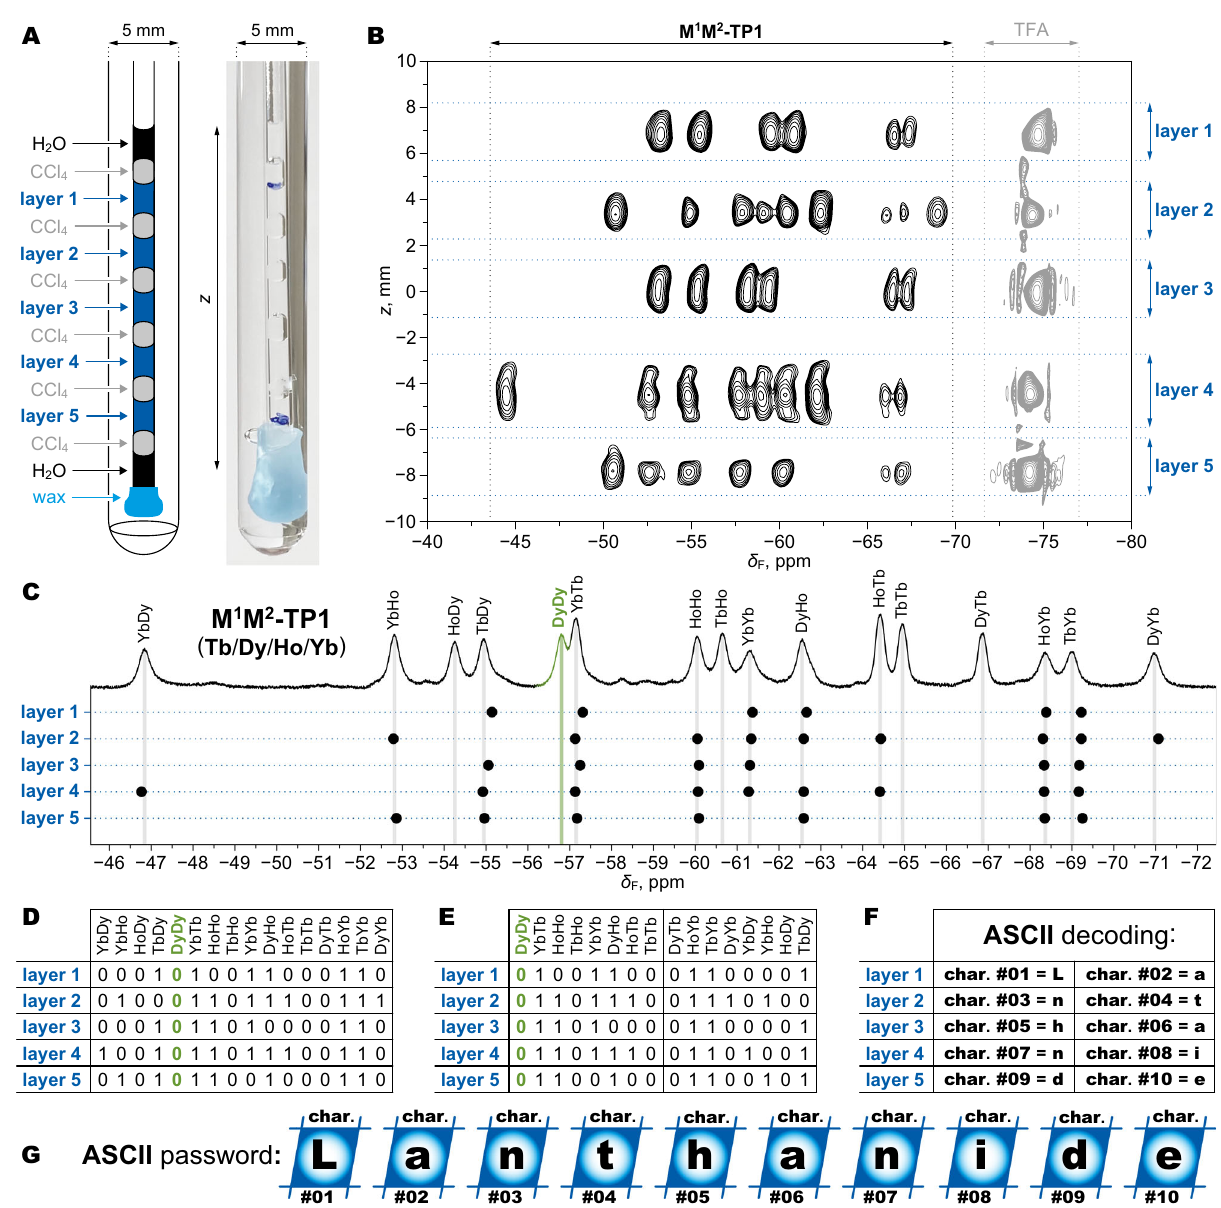
Fig. 8 Password decoding from a single sample with z -resolved NMR. A Physical realization of a single NMR sample containing 5 different mixtures of M 1 M 2 -TP1 compounds encoded with Tb 3 + /Dy 3 + /Ho 3 + /Yb 3 + ions. Aqueous solutions (in MOPS/NaOH buffer, pH = 7) of the mixtures (layers 1 – 5) are separated by layers of CCl 4 . The capillary is submerged in D 2 O. B Z -resolved 19 F NMR spectrum (470 MHz, T = 298.1 K) of the sample from panel A shows signals of the M 1 M 2 -TP1 compounds and internal standard (TFA, tri fl uoroacetic acid) resolved for the layers along the z -axis. Shifts from different layers are not perfectly aligned due to bulk magnetic susceptibility (BMS) effects that varied for each layer. C Evaluation of the signals from panel B by comparison with an independently obtained 1D NMR spectrum of a mixture containing all 16 M 1 M 2 -TP1 compounds. Note that peaks of DyDy and YbTb are close but distinguished in the 1D spectrum. Black dots mark shifts from the z -resolved spectrum after correcting for BMS effects in each layer (referencing to TFA). Good match is achieved between expected shifts (vertical lines) and determined shifts (black dots). D Binary representation of the information from C. E Final table of the binary codes for 10 ASCII (American Standard Code for Information Interchange) characters encoded in the sample. Relative to D, the binary codes are rearranged to start at the position of DyDy (green shading), which is not used to avoid confusion with YbTb. F ASCII characters obtained by conversion from the binary codes in E with indication of their order in a password. G The fi nal decoded 10-character